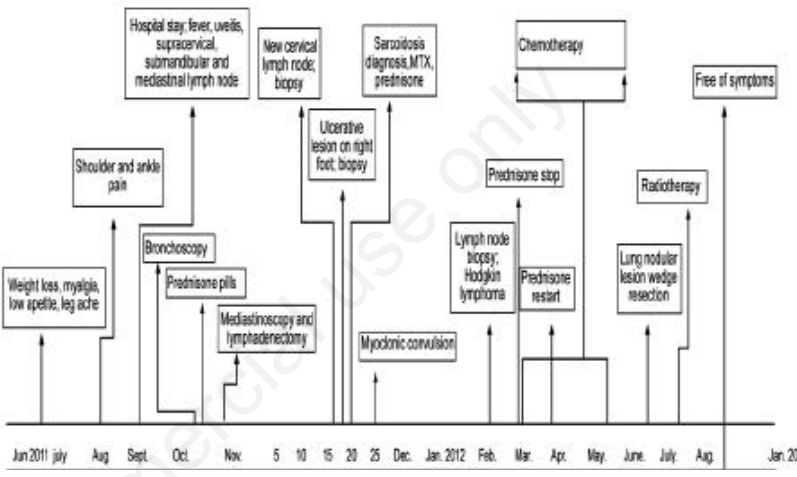
Figure 1. Patient’s disease timeline.